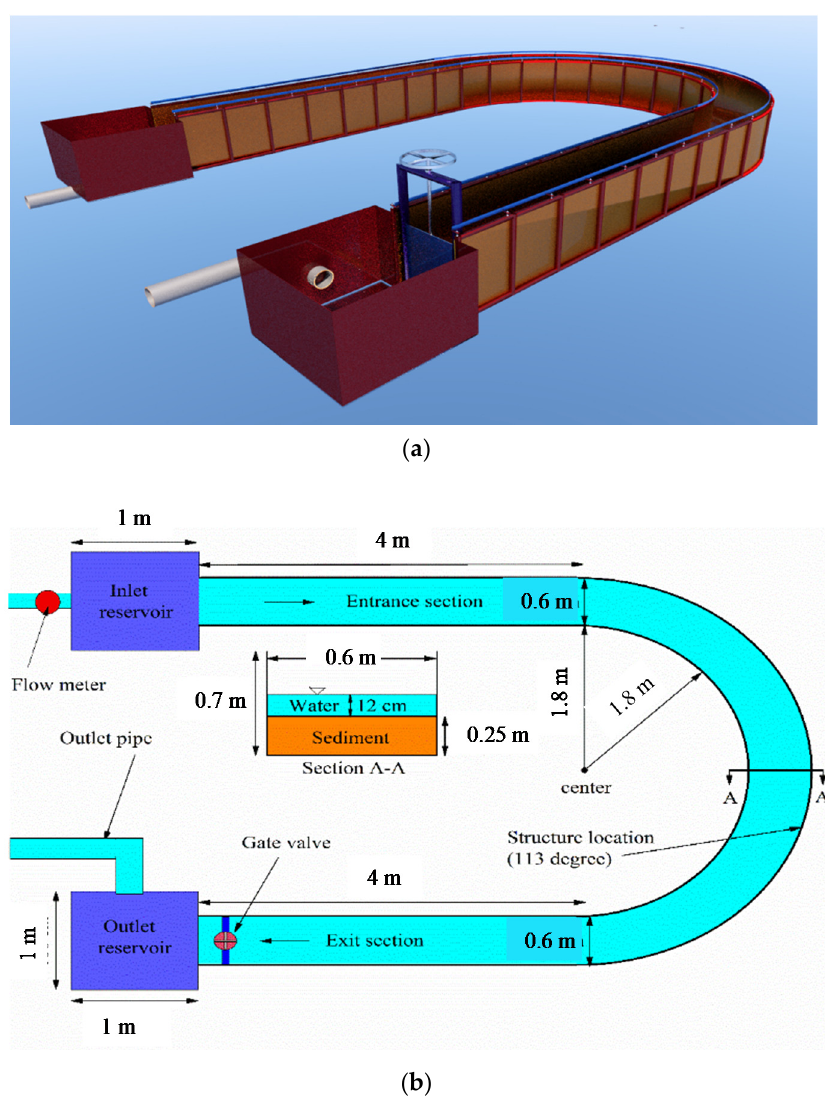
Figure 1. ( a ) 3D view; and ( b ) a schematic plan of the channel bend used in this investigation.